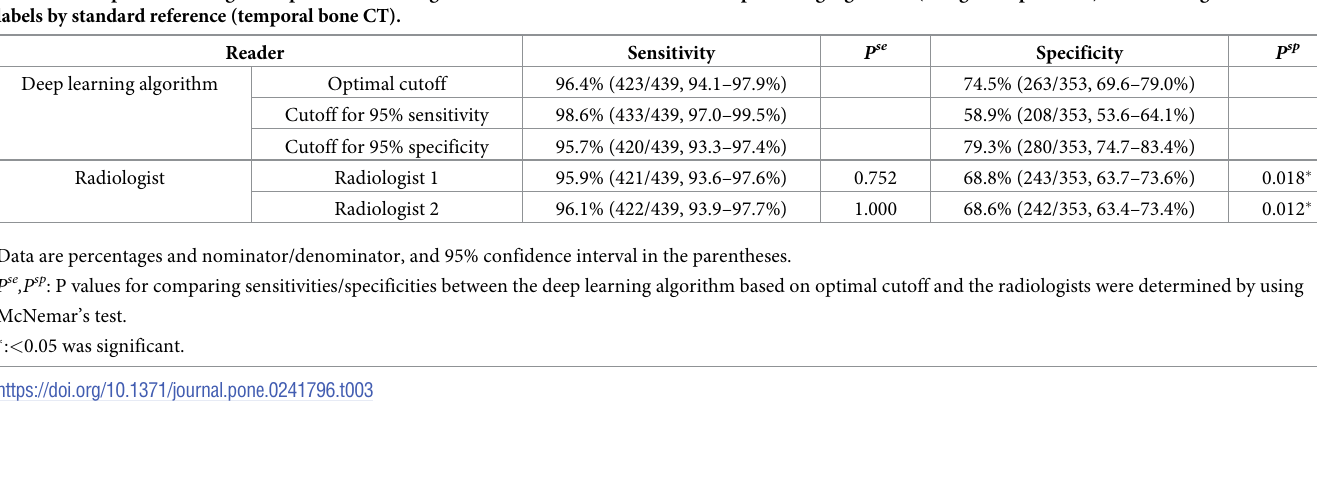
algorithm of the three test sets are shown in Table 4 . The sensitivity and specificity of the gold